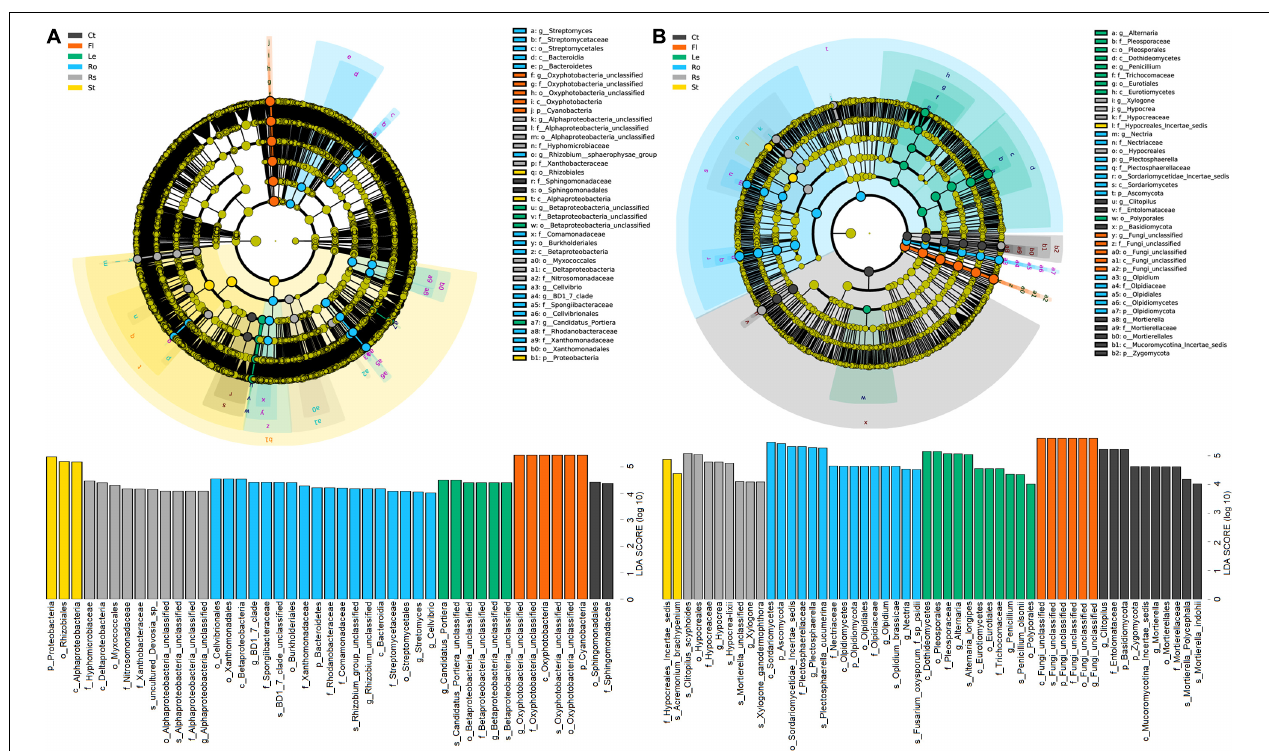
FIGURE 4 | Linear discriminant effect size (LEfSe) of bacterial (A) and fungal (B) communities associated with hemp plants with a linear discriminant analysis (LDA) score higher than 4.0 and p -values less than 0.05. Ct, Rs, Ro, St, Le, and Fl represent bulk soil, rhizosphere soil, root endosphere, stem endosphere, leaf endosphere, and flower endosphere, respectively.